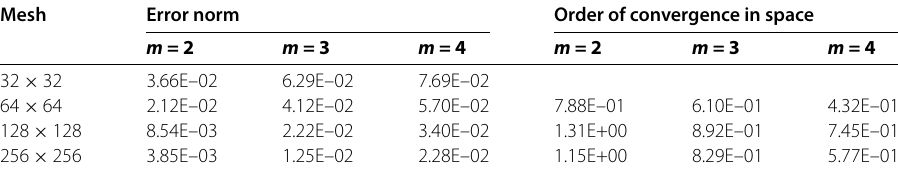
Table 1 Computed error norms and the order of convergence for Test 1 Mesh Error norm Order of convergence in space m = 2 m = 3 m = 4 m = 2 m = 3 m = 4 32 ×